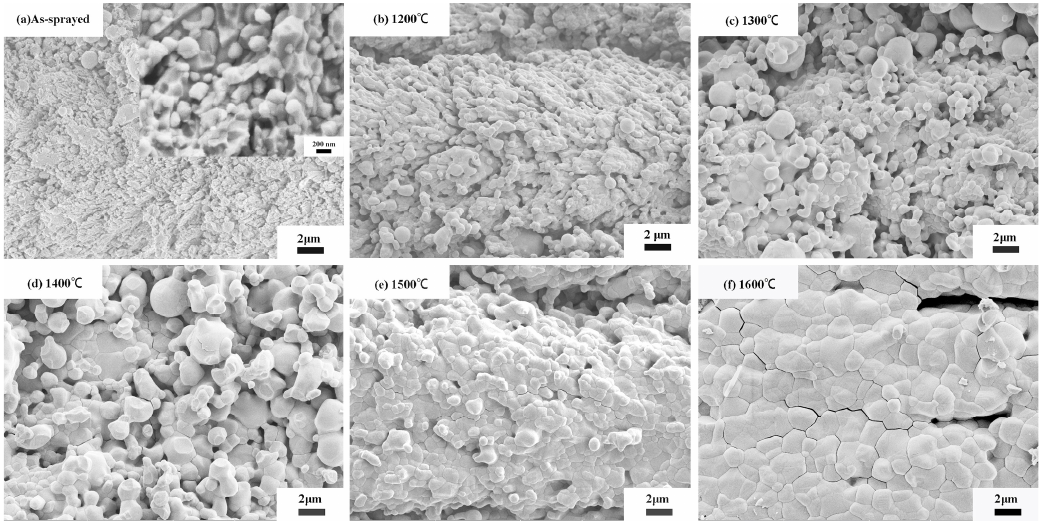
Figure 2. SEM micrographs of fracture surface of PS–PVD TBCs as a function of temperature: ( a ) as-sprayed; ( b ) 1200 ◦ C; ( c ) 1300 ◦ C; ( d ) 1400 ◦ C; ( e ) 1500 ◦ C; ( f ) 1600 ◦ C.